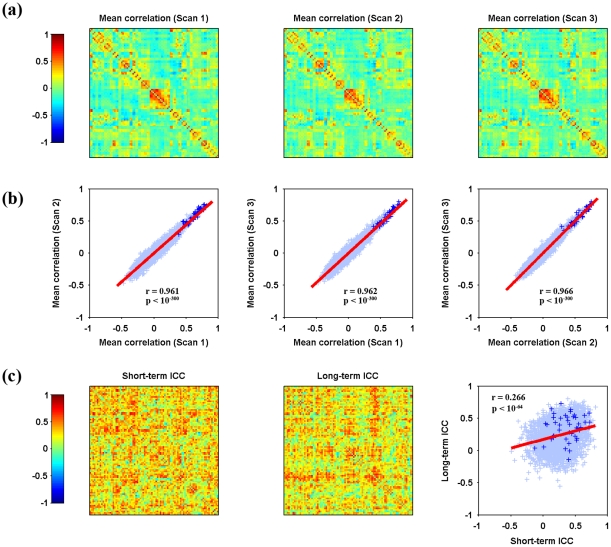
Spatial similarity and TRT reliability patterns of S-AAL-based RSFC.Mean Pearson correlation matrices (a), consistency of overall patterns between mean matrices (b) and TRT reliability of individual connections as well as the relationship between short-term and long-term reliability (c) are illustrated. The mean correlation matrices exhibited high similarity from both visual inspection (a) and quantitative spatial correlation analyses (b). Further TRT reliability analyses revealed a portion of connections exhibiting fair to excellent reliability (c, also see Fig. 2). Moreover, short-term reliability was significantly (p<0.05) correlated with long-term reliability among connections (c). Functional connections linking inter-hemisphere homotopic regions, as highlighted by plus signs (+), showed high connectivity strength and many of them exhibited high reliability. TRT, test-retest; RSFC, resting-state functional connectivity; S-AAL, structural ROIs from Anatomical Automatic Labeling atlas. Of note, the structural ROIs were listed as in Table S1.